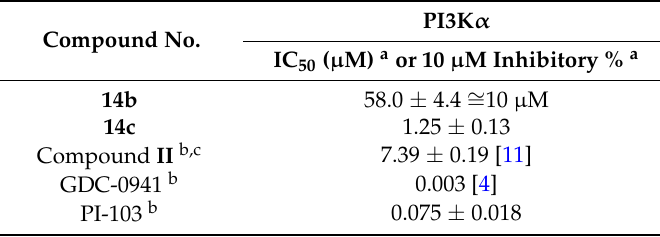
Table 2. PI3K α kinase activity of selected compounds and positive